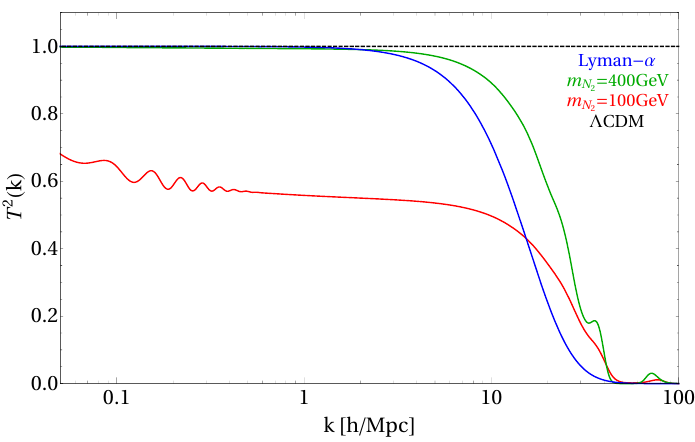
Figure 2 . Transfer function for the same benchmark points as in (cid:12)gure 1. The constraint from structure formation, using m TR = 2 keV is shown in blue. HNL masses of around 100 GeV clearly violate this constraint while the green line (corresponding to m N the data. The black dashed line represents